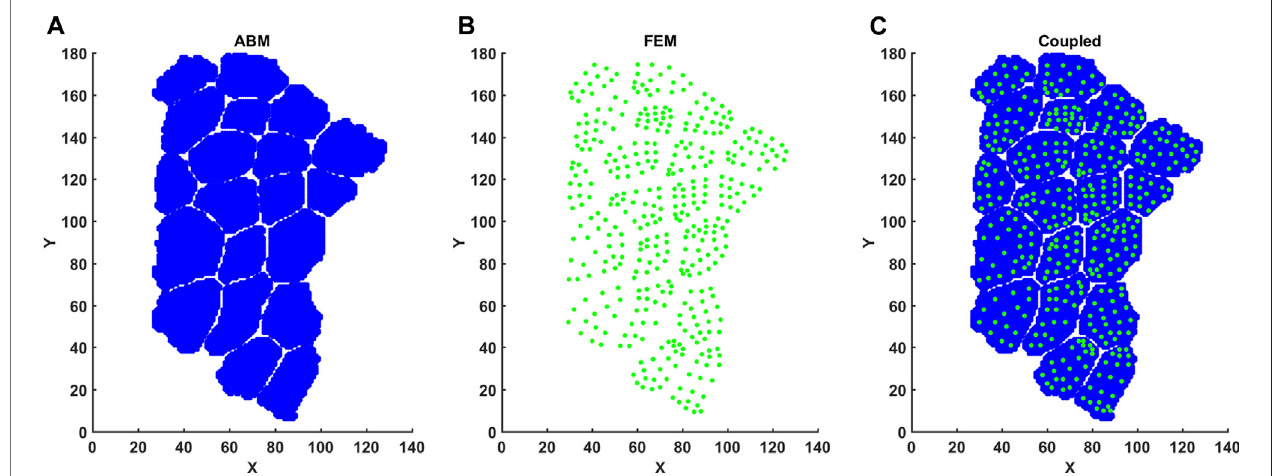
FIGURE3| MappingFEelementcentersintoABMcoordinatespace. (A) FEelementcenterswerecalculatedbasedonnodalpoints. (B) ABMpixelswereimported with associated X, Y coordinates. (C) Element center coordinates and associated strain per element were then registered to ABM coordinates.